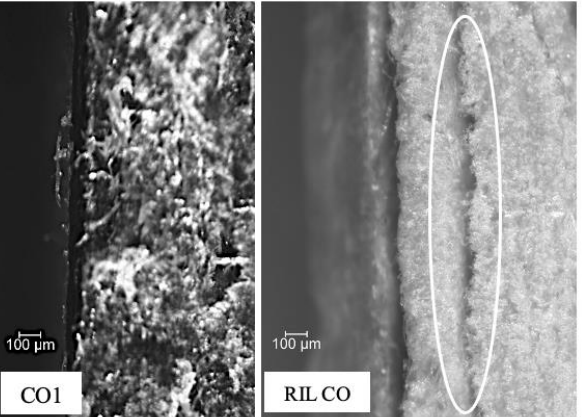
Figure 8. Microscopic comparison (×4) between samples done by partial dissolution with pure [BMIM][Ac] and cotton (CO1); recycled [BMIM][Ac] and cotton (RIL CO).